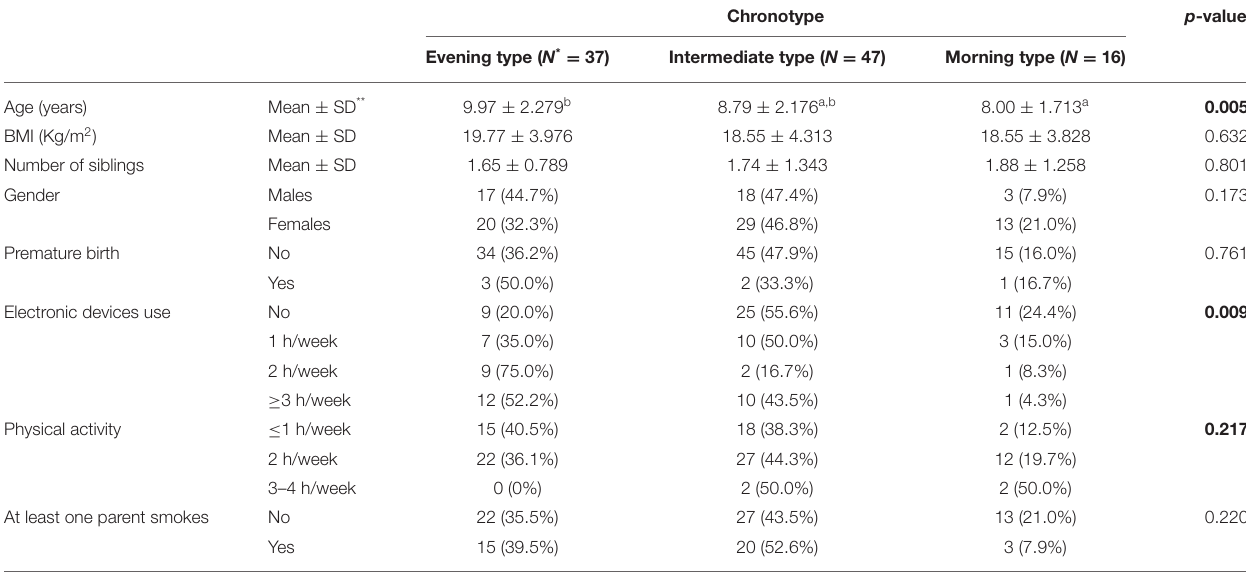
TABLE 2 | Association between chronotype categories and participants’